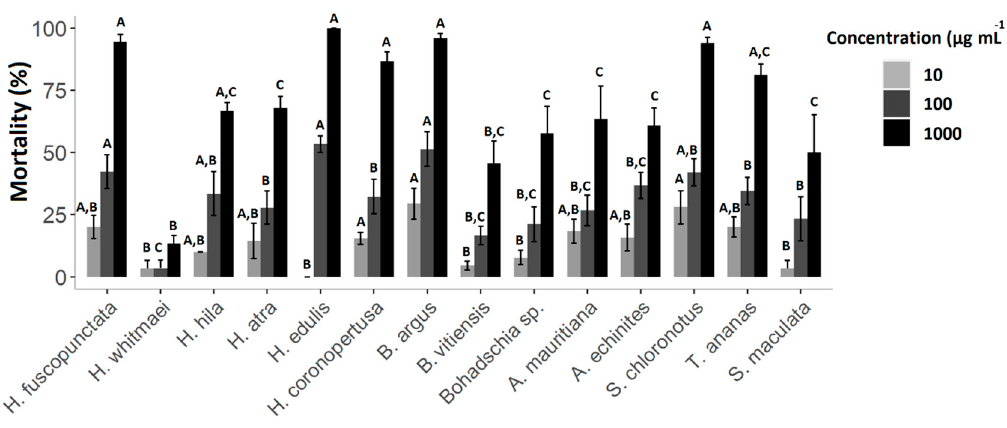
standard error for the four replicated sea cucumber species (i.e., H. atra , A. echinites , S. chloronotus and